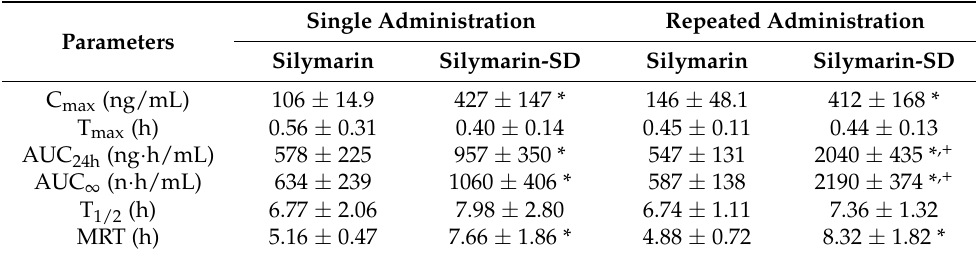
Table 1. Pharmacokinetic parameters of silybin.